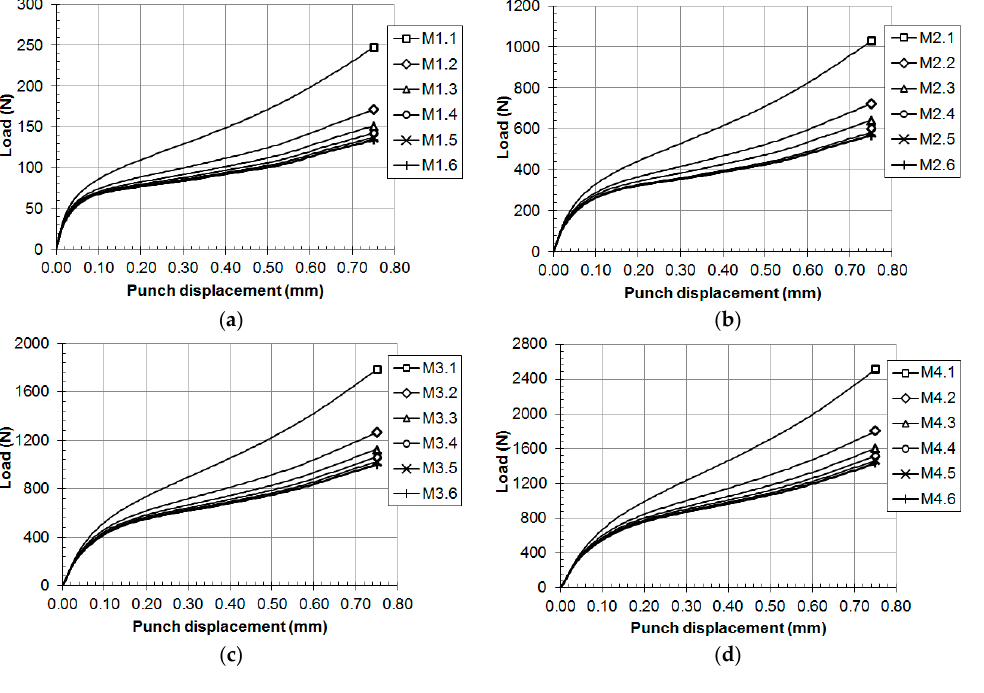
Figure 8. SPT curves for the hypothetical materials: ( a ) M1.x, ( b ) M2.x, ( c ) M3.x and ( d ) M4.x.